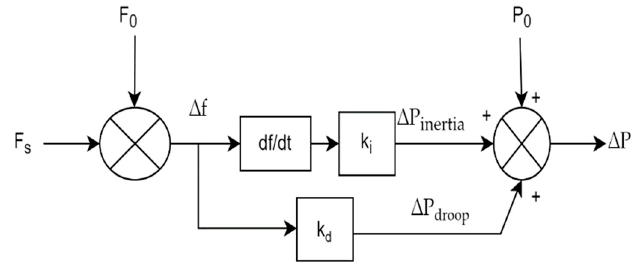
Figure 2. The frequency control regulation block.